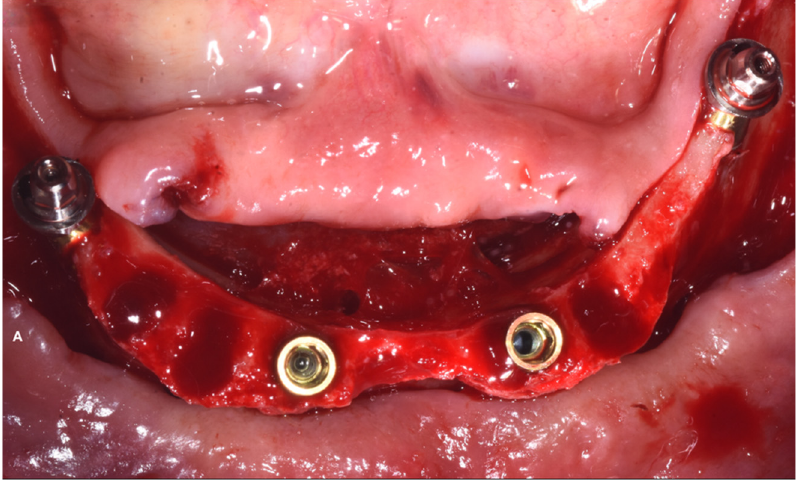
Figure 6. Implant insertion. The two distal implants are connected to two 30° angulated abutments, while the two anterior implants are with no abutments.